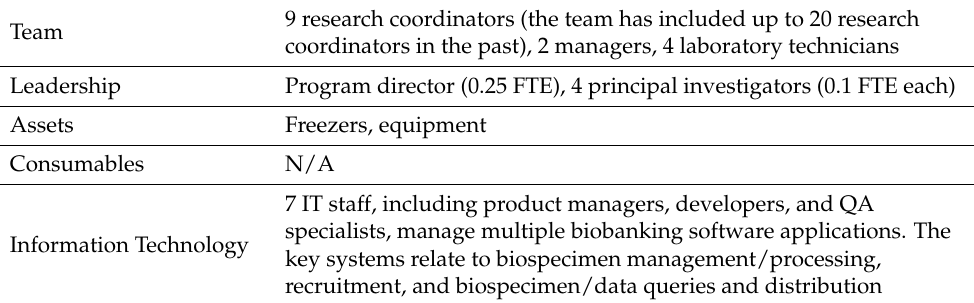
Table 3. Biobank Inputs (June 2022).